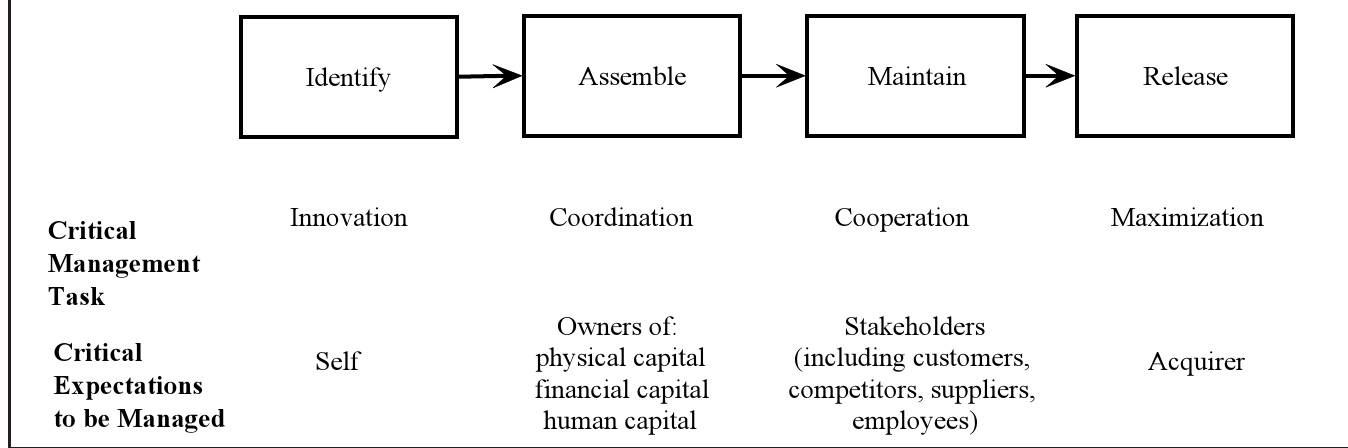
Figure 1. An Entrepreneurial Process Based on Resource Management